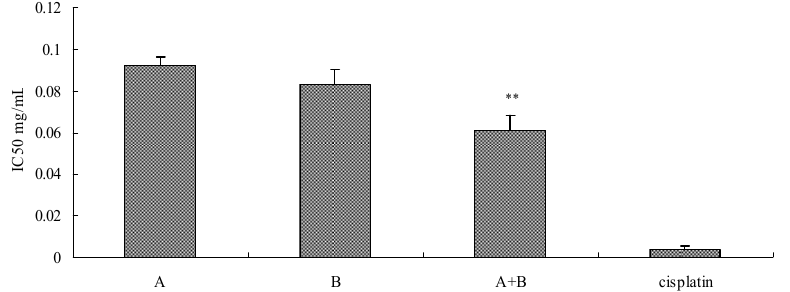
Figure 7. Inhibition ratio of components and its combination on SPC-A-1 cells.